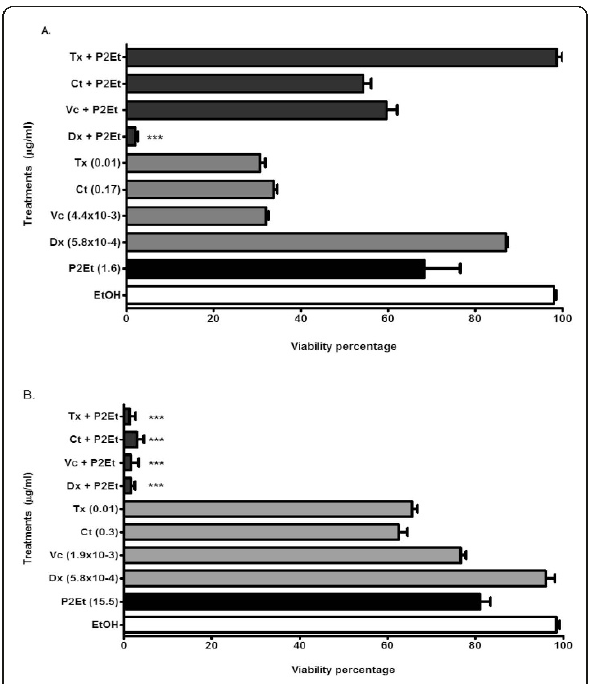
Figure 5 Adjuvant activity of the P2Et fraction on the K562 and MCF7 cell lines . K562 (A) or MCF7 (B) cells were treated with the P2Et fraction or ethanol (negative control) for 6 h, washed and treated with doxorubicin (Dx), vincristine (Vt), camptothecin (Ct) or taxol (Tx) at the concentrations shown over a 48 h period. Cell cytotoxicity was estimated using the MTT assay. Data represent three independent experiments. *** (p <